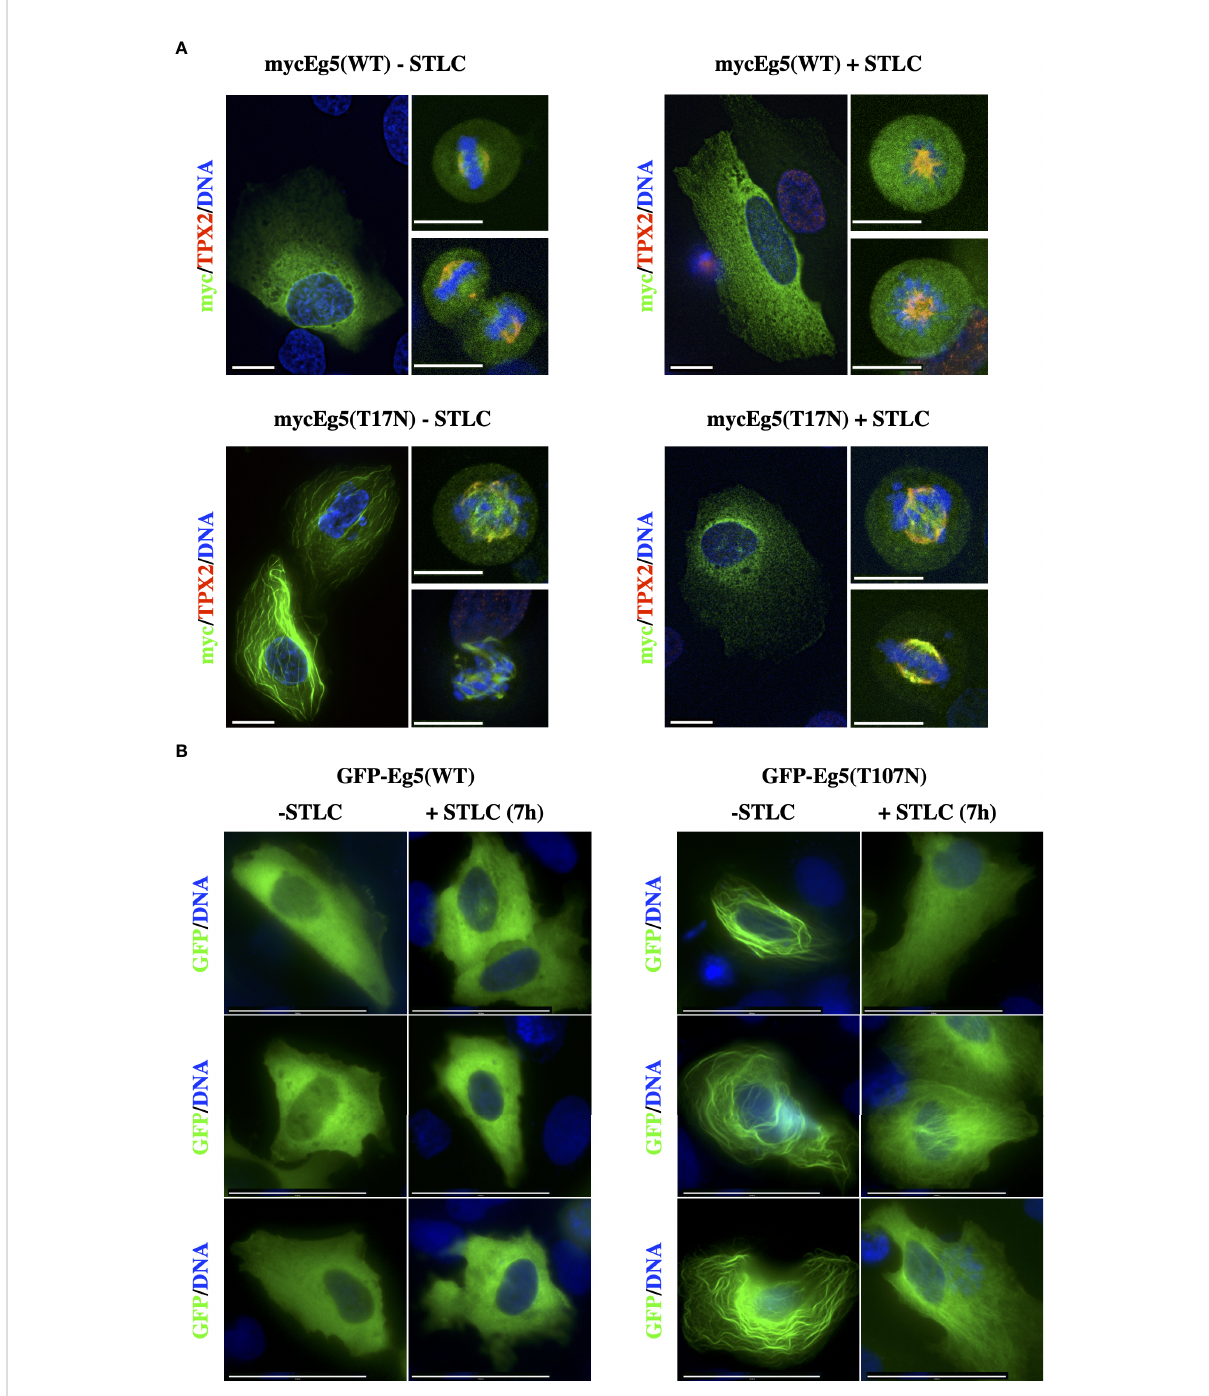
FIGURE 6 STLC resistant Eg5(T107N) variant binds and bundles microtubules in the absence of STLC. (A) Myc-tagged Eg5(WT) and -Eg5(T107N) were transfected for expression in U-2OS cells. Immuno fl uorescence microscopy images of cells untreated or in the presence of STLC (10 m M) 24h post transfection fi xed and stained; Eg5 was detected by an anti-myc (green) and mitotic spindle microtubules were detected by an anti-TPX2 (red) and chromatin by DAPI (blue). (B) GFP-tagged Eg5(WT) and -Eg5(T107N) were transfected for expression in U-2OS cells for 24h and fi xed and stained for indirect immuno fl uorescence microscopy. Scale bar corresponds to 10 m